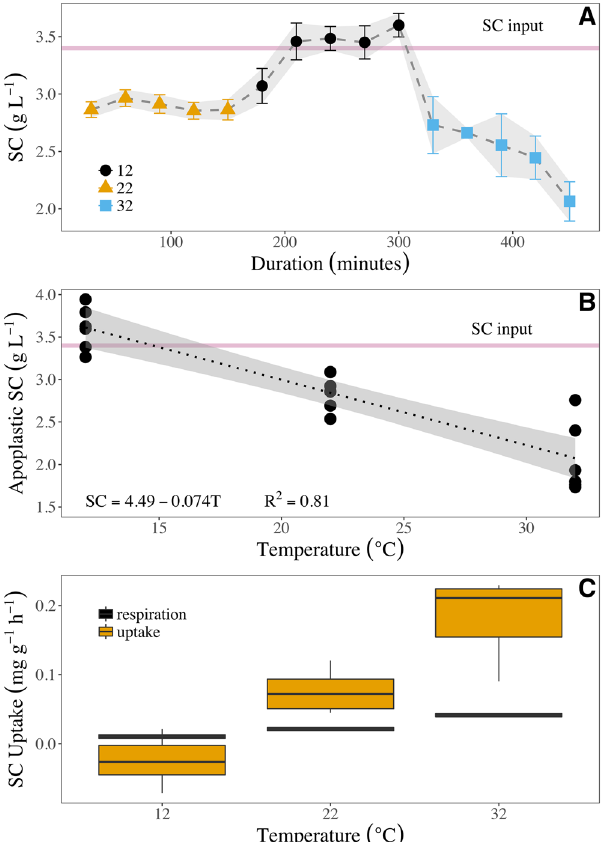
Figure 1. Apoplastic SC concentrations in perfused branch segments at variable temperatures. 15 cm long and 10 mm in diameter branches were submitted to 12 °C (blue circles), 22 °C (green triangles), and 32 °C (red squares) and perfused with sucrose solution. The solution’s input concentration was 3.42 g L − 1 sucrose (red horizontal line) and flow rate was 0.68 g h − 1 . ( A ) SC concentration of perfused solution in branches changing temperature every 150 minutes (from 22 °C to 12 °C and then to 32 °C, 450 minutes total). ( B ) The final SC concentration of perfused solution (after 150 minutes at a given temperature) decreased with temperature in a linear manner (dotted line, R 2 = 0.81, df = 16, p = 1.433e − 7 , grey area denotes 95% confidence intervals).